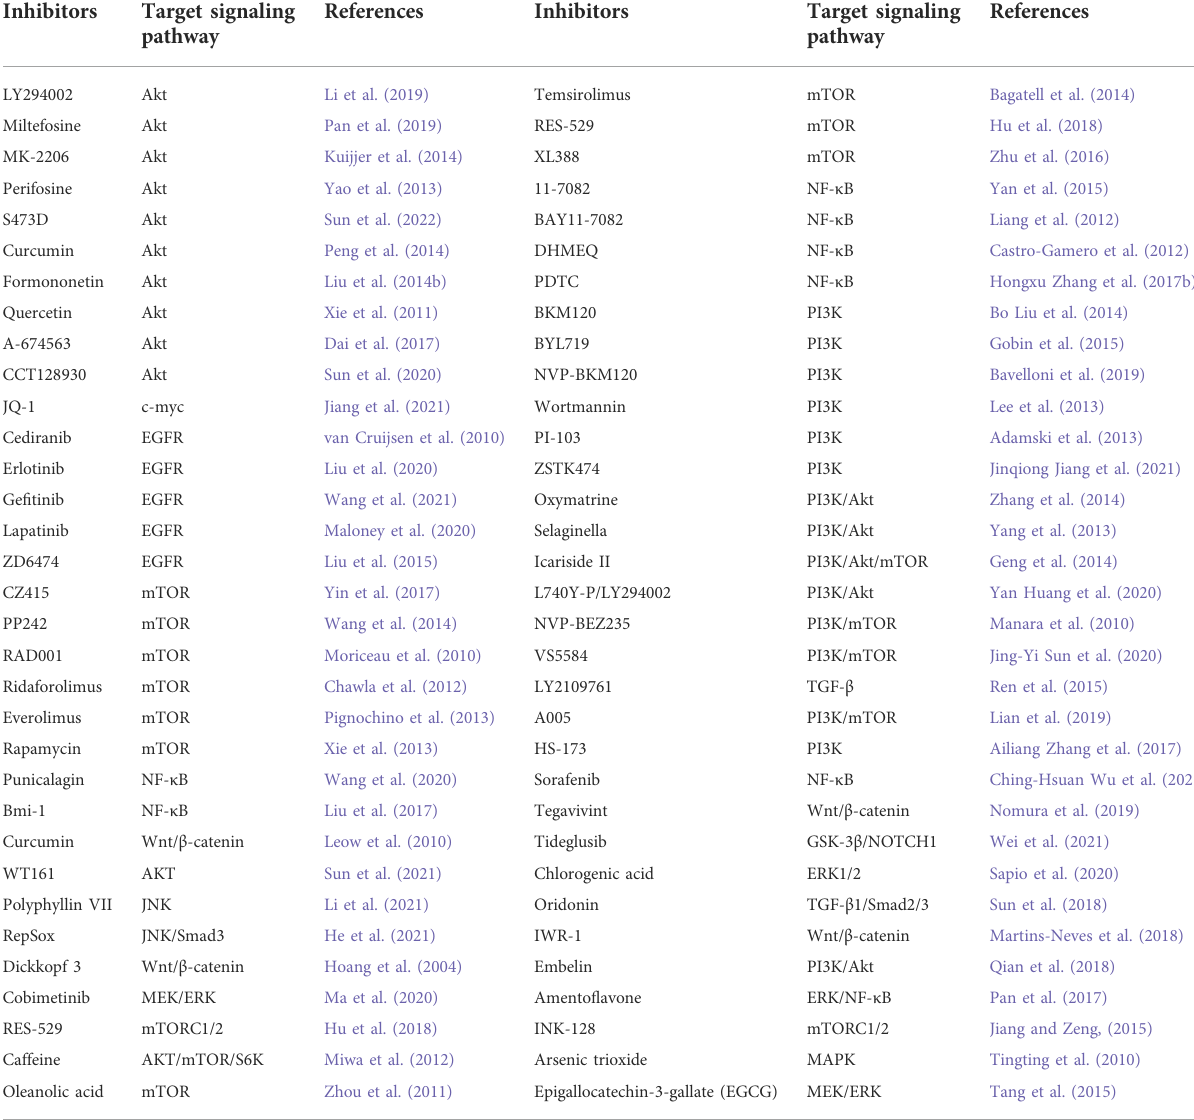
TABLE 2 List of potential small molecule inhibitors and drugs for OS treatment in basic experimental or clinical